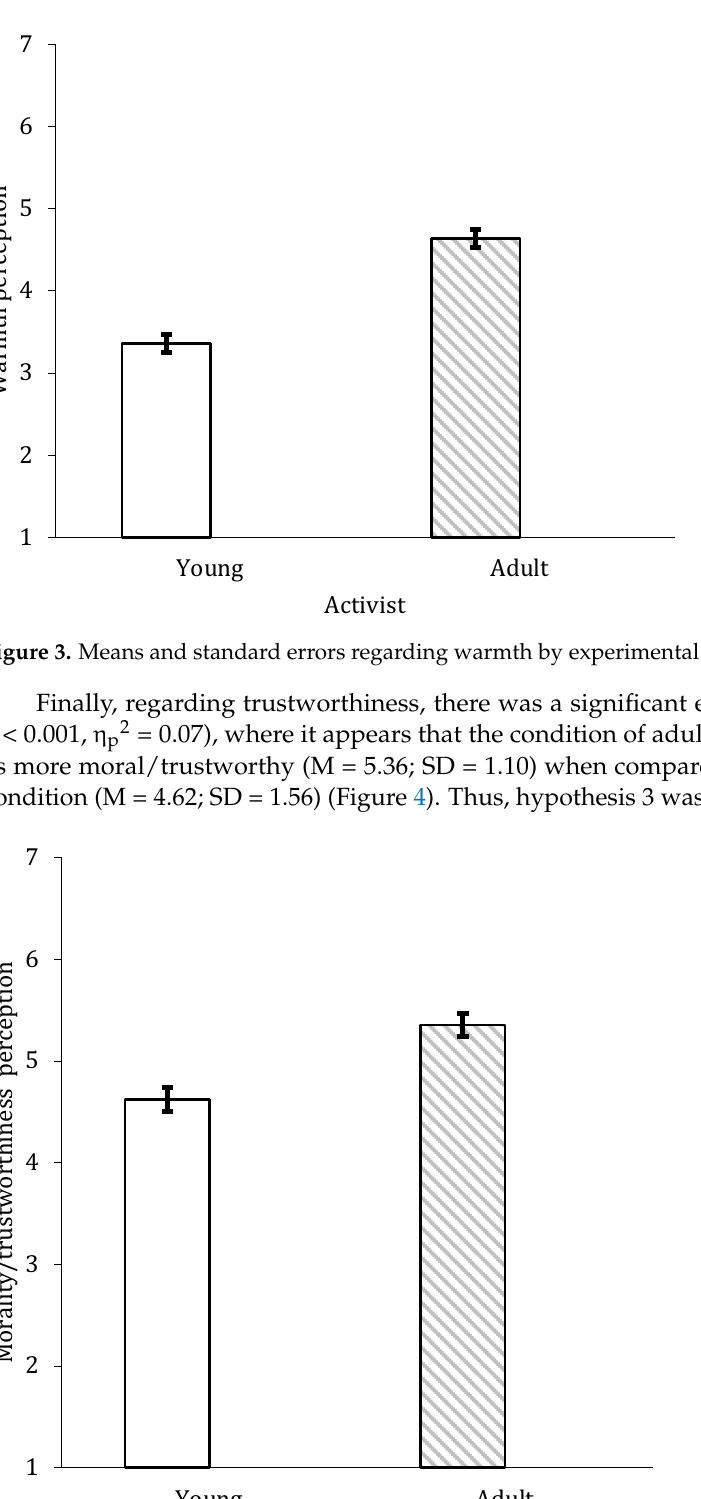
Figure 2. Means and standard errors regarding competence by experimental conditions.